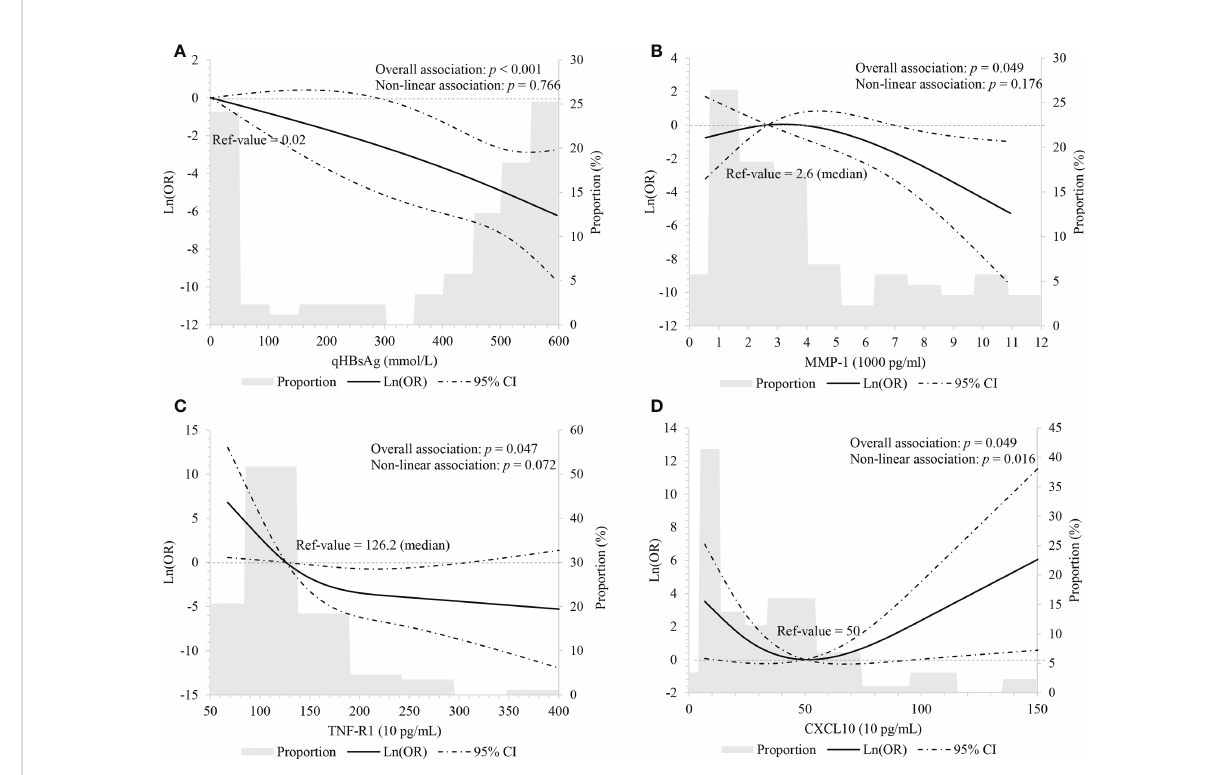
FIGURE 1 Linear association between HBsAg, cytokines and HBsAg loss using restricted cubic spline with three knots (p5, p50 and p95) (A) HBsAg, adjusting for age, ALT level, HBeAg status and interferon treatment; (B-D) MMP-1, TNF-R1, and CXCL10, adjusting for age, HBsAg level, ALT level, HBeAg status and interferon